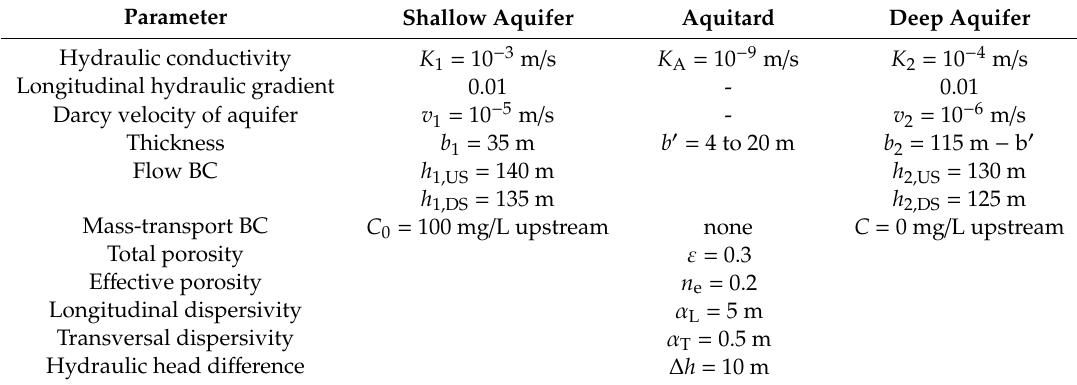
Table 1. Parameters assumed in the